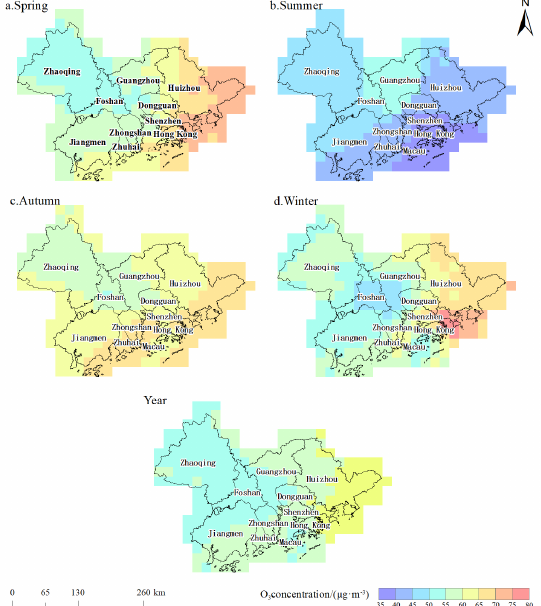
Figure 4. Average annual and seasonal distribution of O3 in the GBA in 2017. ( a – d ) represents the four seasons.